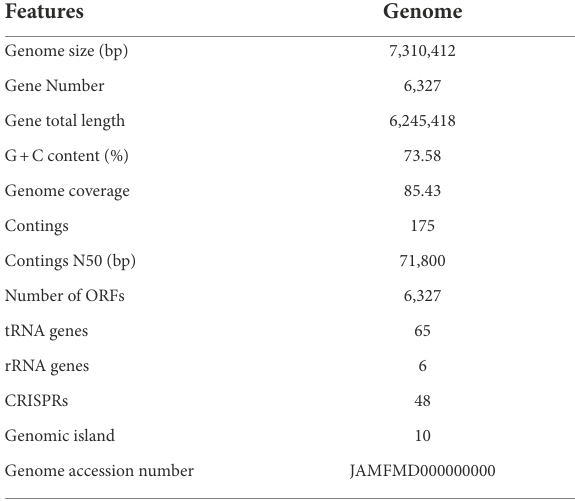
TABLE 1 Genome features of Streptomyces albidoflavus St-220.